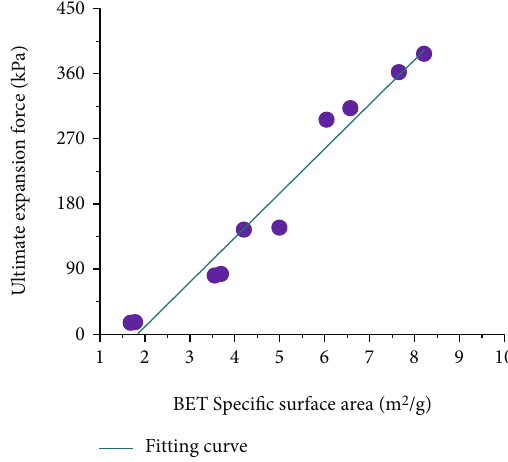
Figure 15: The relationship between BET-speci fi c surface area and expansion